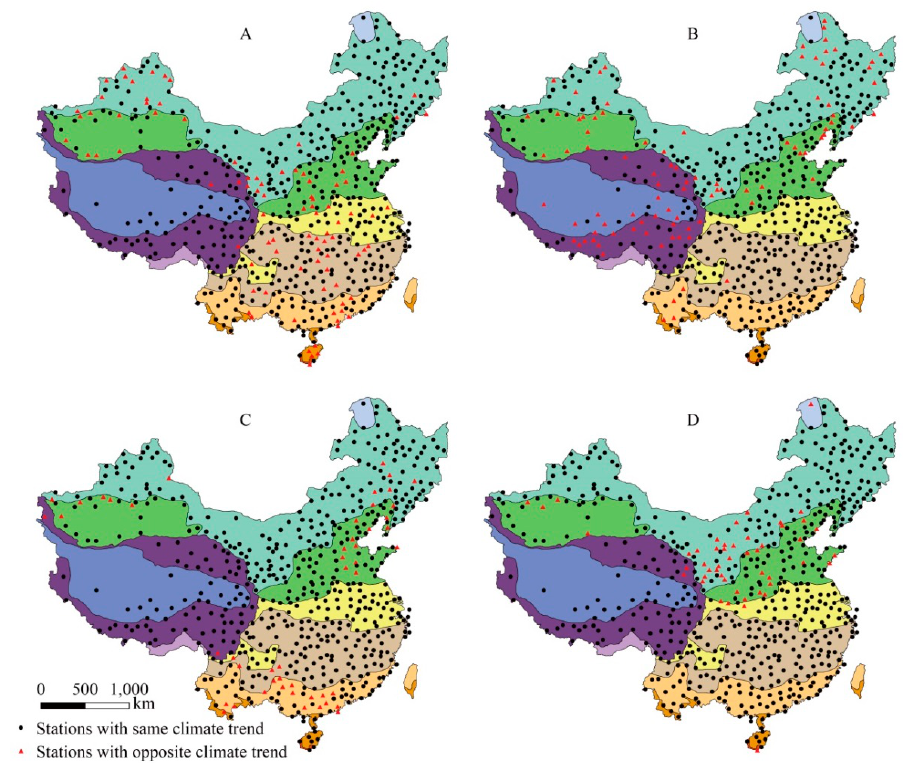
Figure 3. Climate trend of daily mean temperature for January 1st ( A ), April 1st ( B ), July 1st ( C ) and October 1st ( D ).